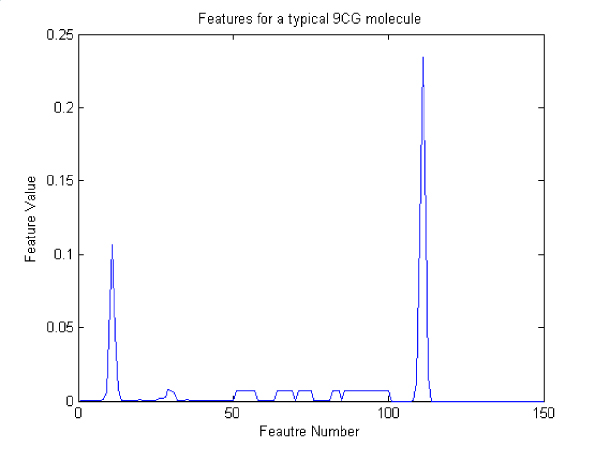
Features for a typical 9CG type molecule.